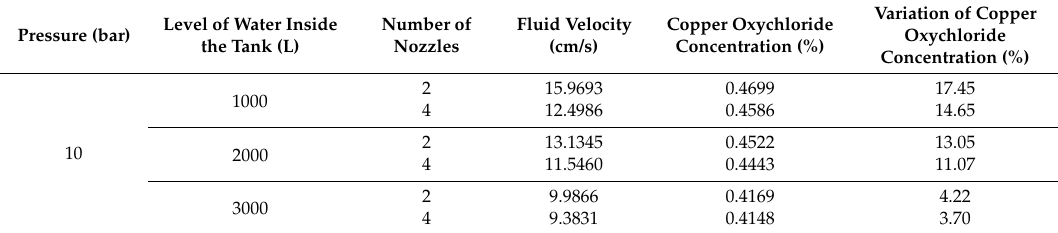
Table 7. Fluid velocity inside the tank and concentration of copper oxychloride at the outlet of the sprayer as a function water level inside the tank and the number of activated nozzles. Variation of Copper Level of Water Inside Number of Fluid Velocity Copper Oxychloride Pressure (bar) Oxychloride the Tank (L) Nozzles (cm/s) Concentration (%) Concentration (%) 1000 10